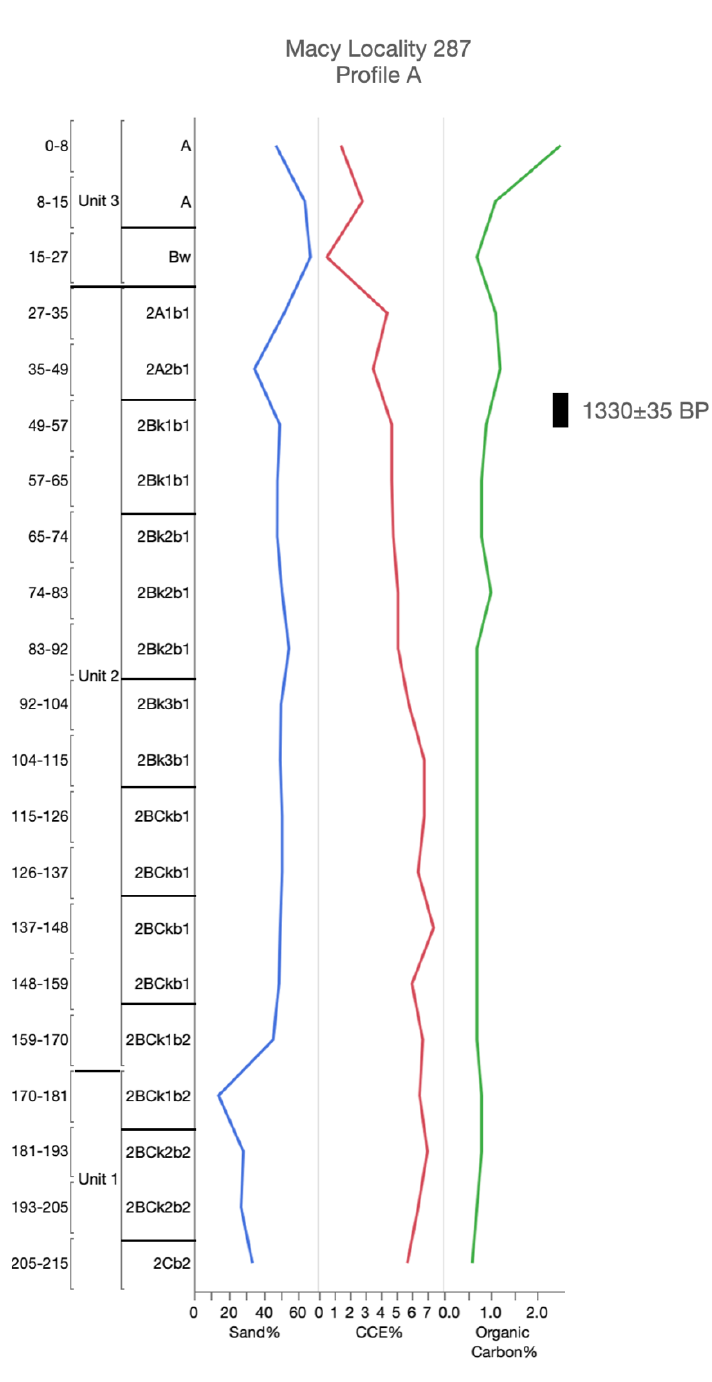
Figure A13. Accepted radiocarbon ages and soil and sediment analysis at Macy Locality 287, Profile A — Post research area, northwest, Texas. CCE = calcium carbonate equivalence.